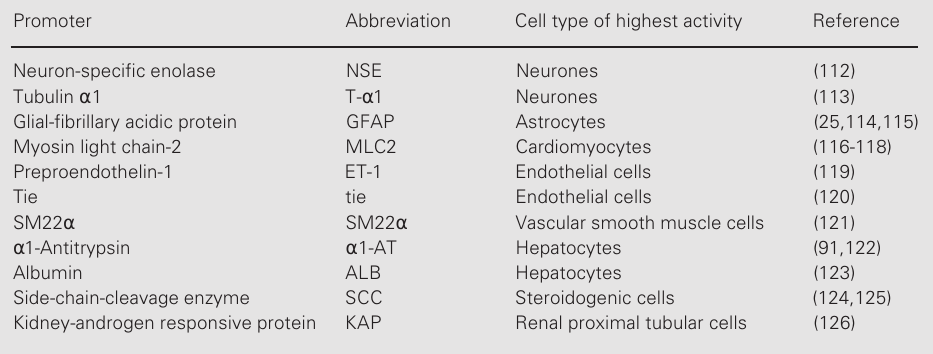
Figure 1 - Generation of trans- genic rodents. A few copies of the DNA construct are injected into the male pronucleus (1a) of a fertilized oocyte, which is then transferred into the oviduct of a pseudopregnant foster mother (1b). The resulting offspring is analyzed for the presence of the transgene by Southern blotting with a specific